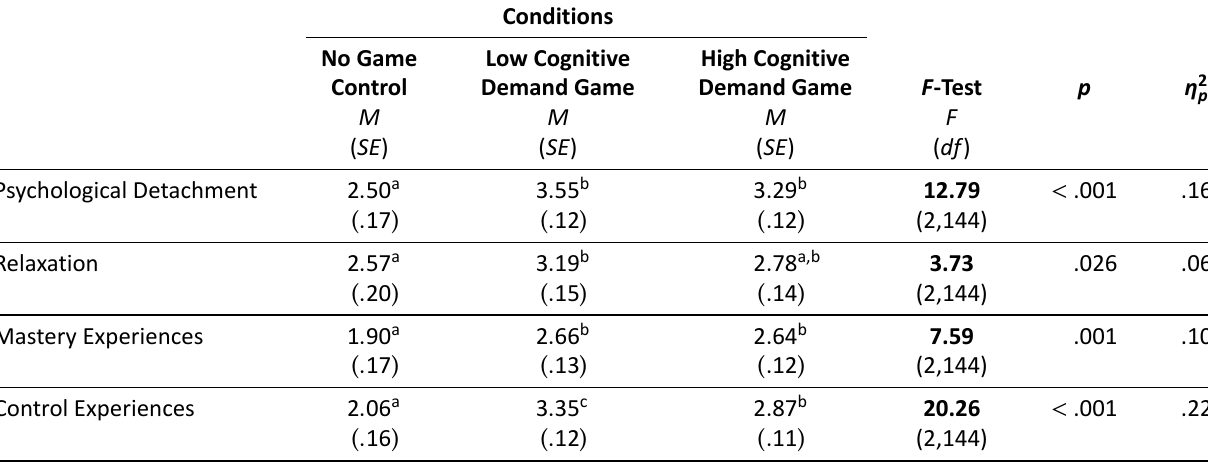
Table 2. Univariate analyses and simple comparisons between conditions for all recovery experiences with previous gaming experiences held constant at a value of